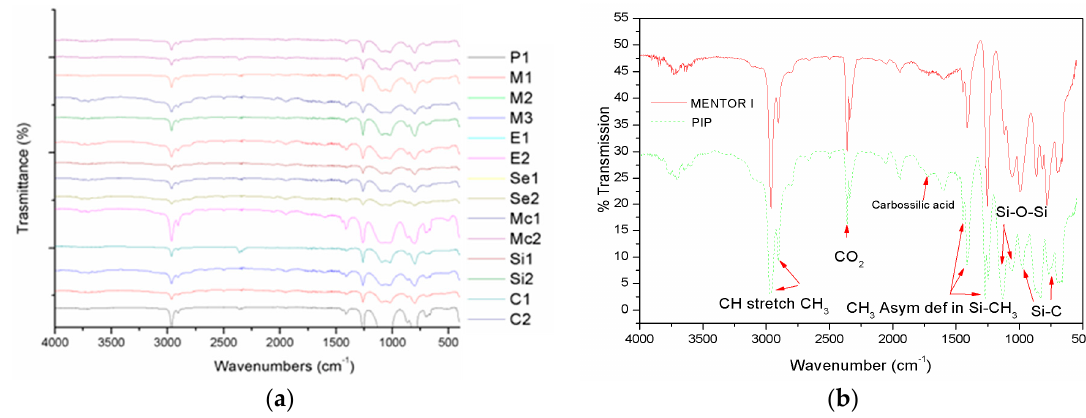
Figure 2. ( a ) FT-IR spectra of silicone gels extracted from all samples; ( b ) FT-IR analysis of silicone gel extracted from PIP I (PIP II completely overlaps to PIP I) and a never-implanted prosthesis, as a reference of “pure” PDMS material.